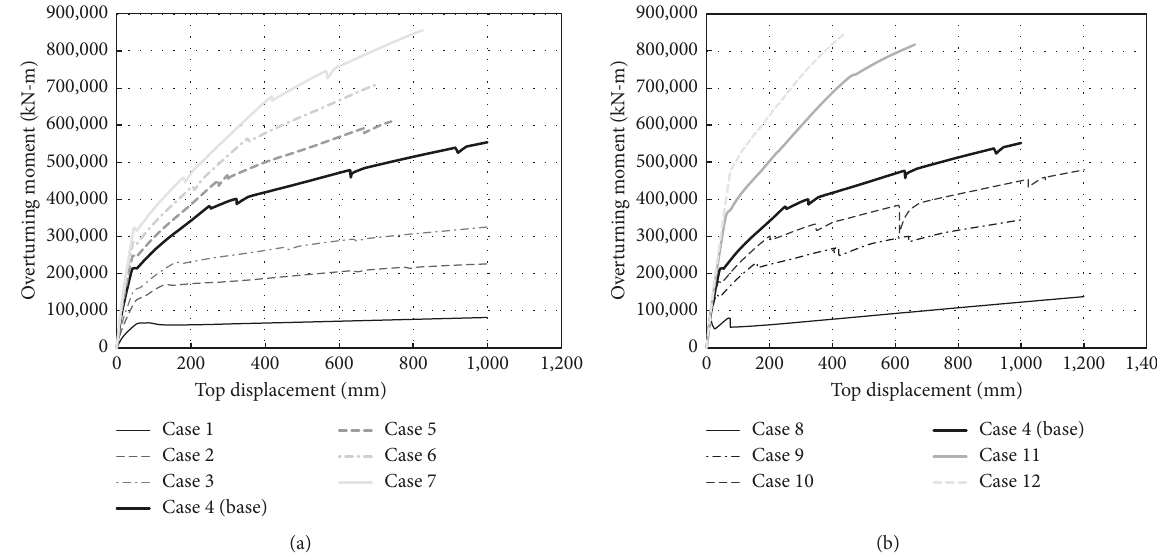
Figure 10: Parametric analysis results along with restraining abutments. (a) Variation in sectional area. (b) Variation in reinforcement steel.